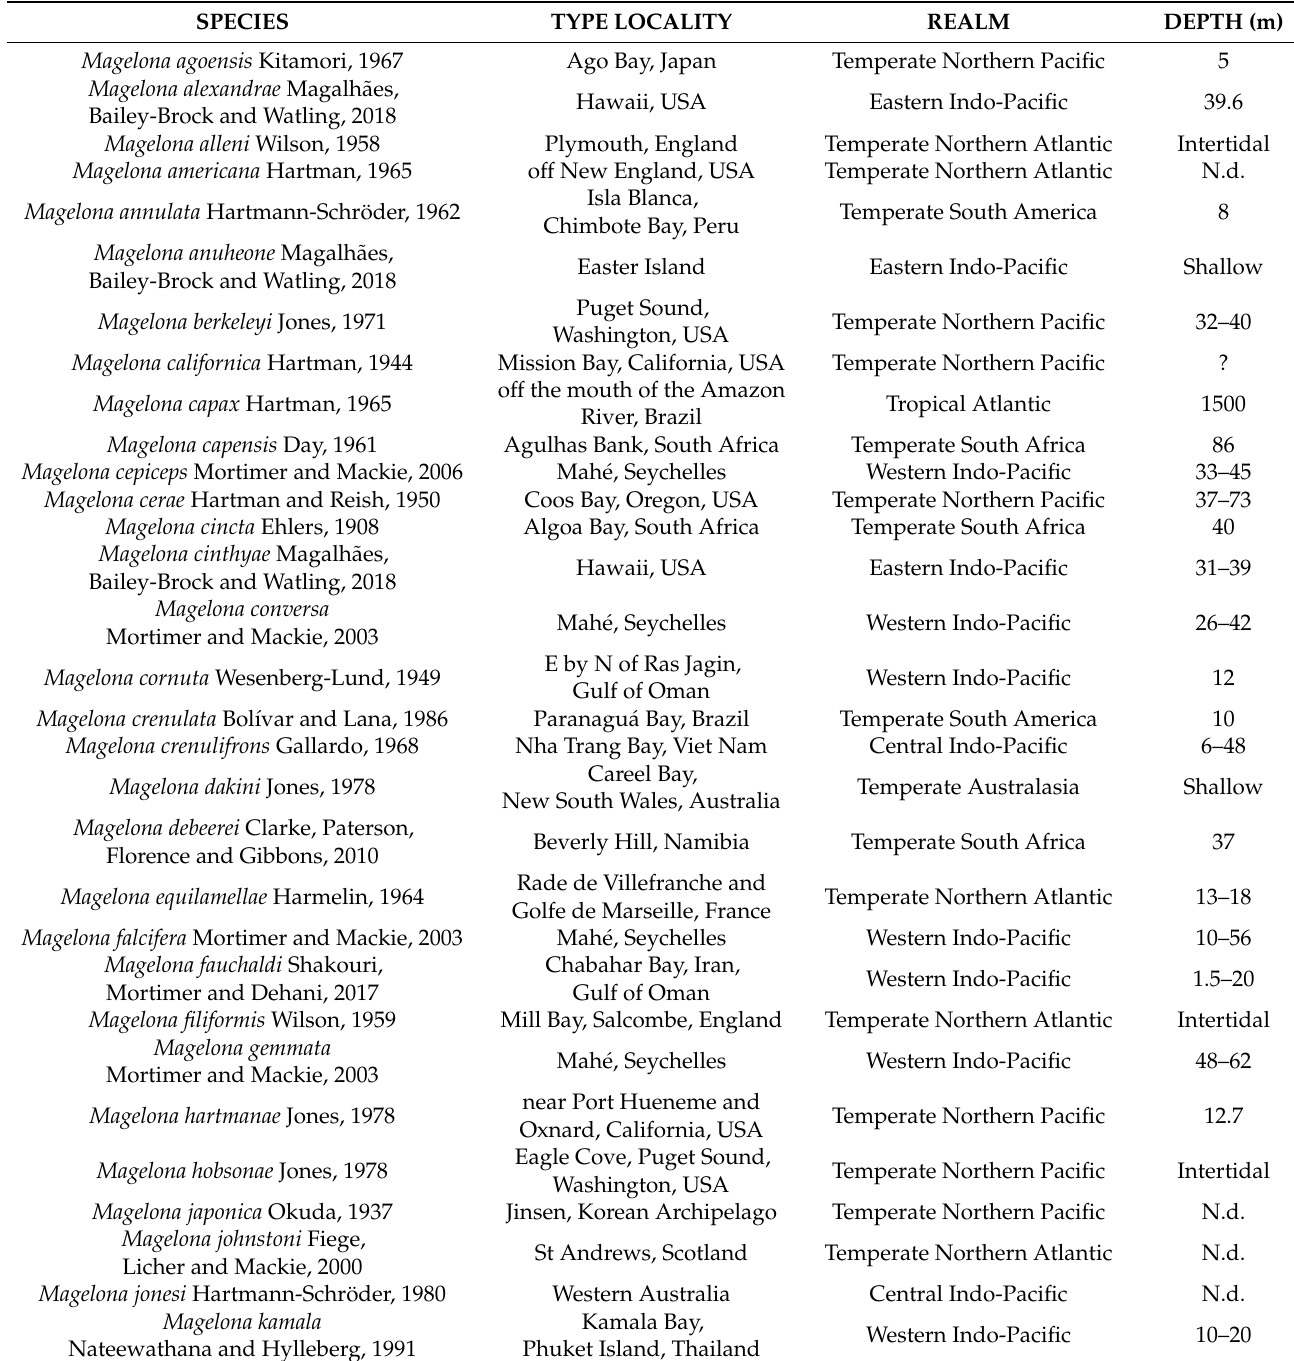
Table A1. Magelonid valid species (according to WoRMS), type locality, assigned marine realms (sensu [86]), and depth of type locality. N.d. = no